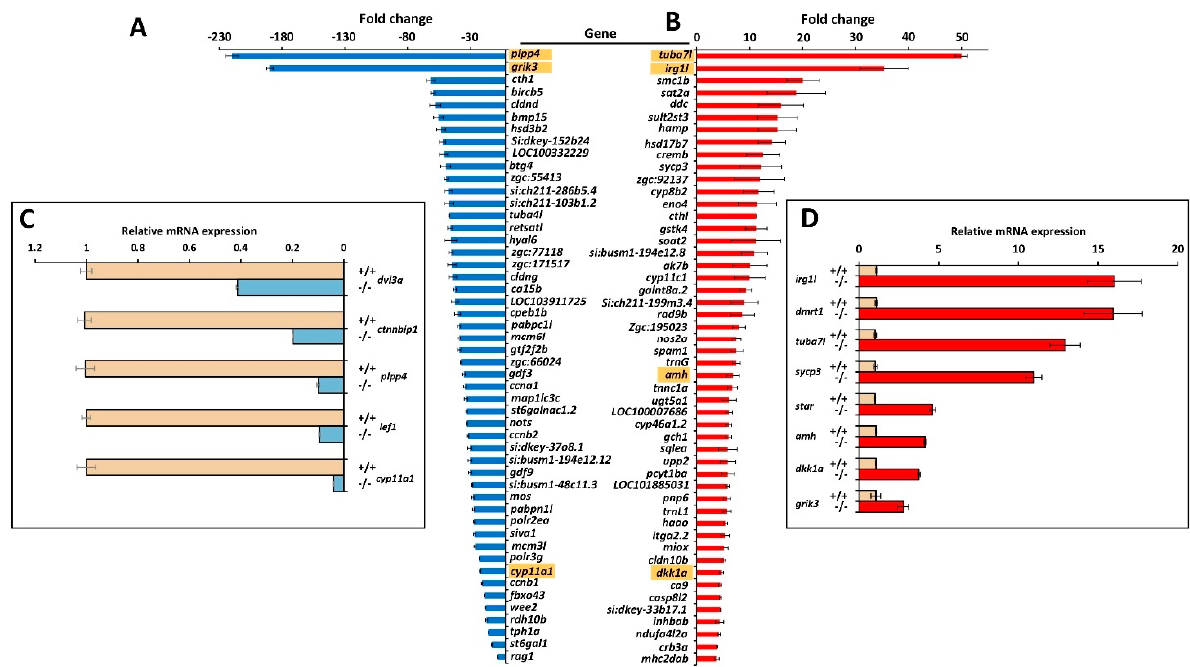
Figure 10. Top-50 DEGs in myoc KO male versus wild-type male zebrafish. Down- ( A ) and upregulated ( B ) genes identified by high throughput RNA sequencing with significant differences in the four comparisons (KO1 vs. WT1, KO1 vs. WT2, KO2 vs. WT1 and KO2 vs. WT2). The golden background indicates genes that were analysed by qRT-PCR. Confirmation by qRT-PCR of differential gene expression of selected down- ( C ) and upregulated ( D ) genes.